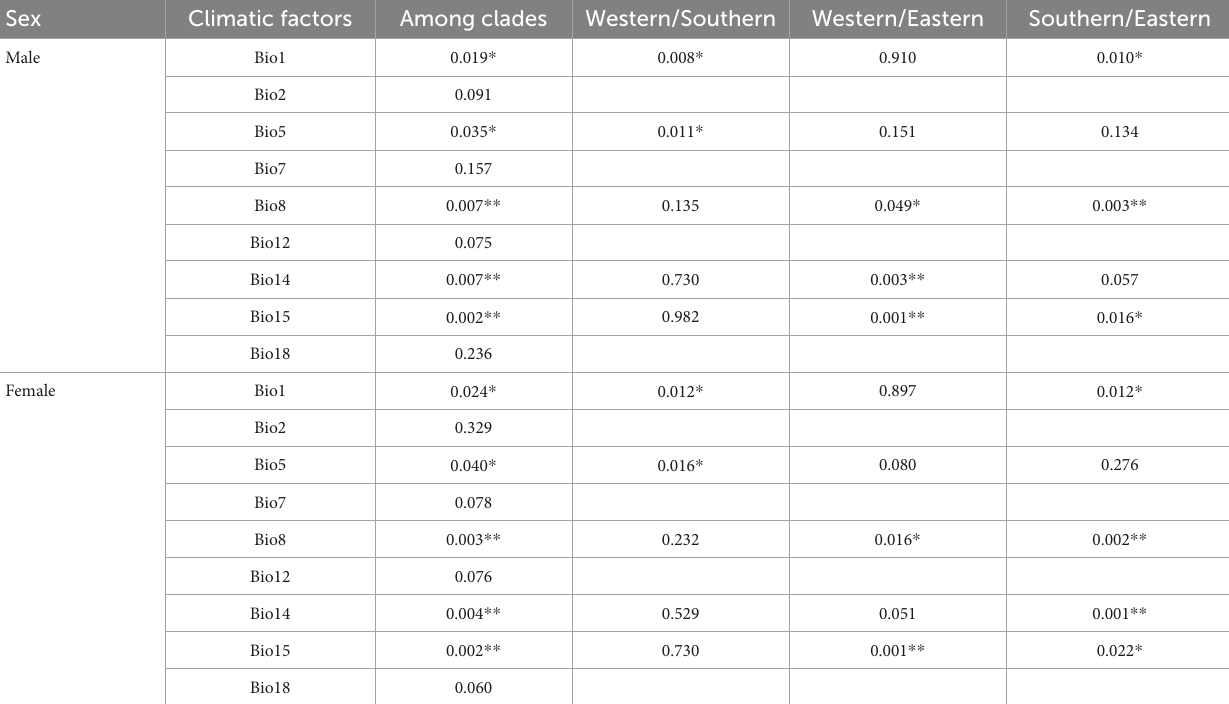
TABLE 4 Kruskal–Wallis analysis based on nine bioclimatic factors between clades of Odorrana graminea sensu stricto. Sex Climatic factors Among